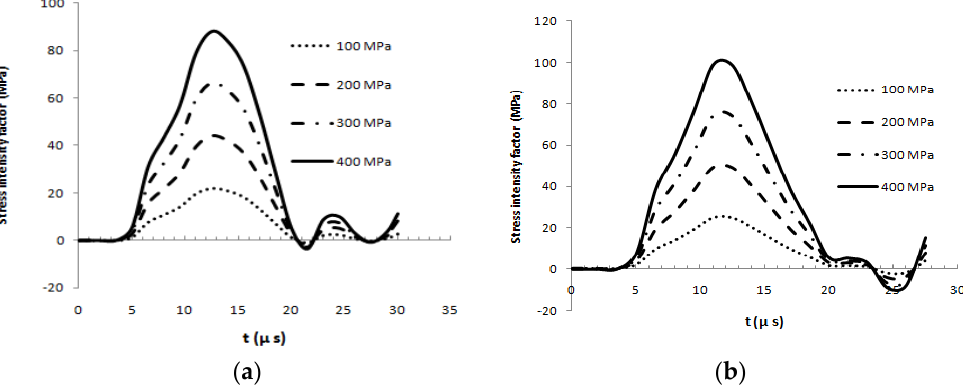
Figure 8. Effect of impact energy level on DSIF of ( a ) PZT-5H composite and ( b ) PZT-4 composite.